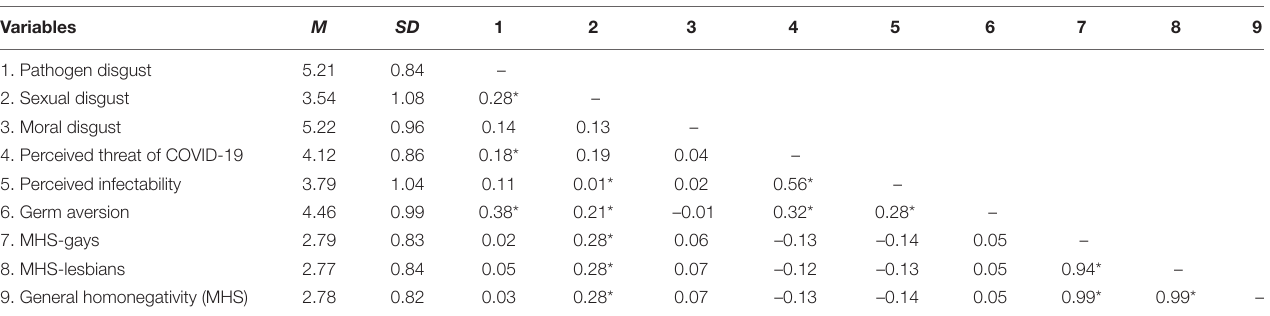
TABLE 1 | Means, standard deviations, and correlations among study variables ( N = 500).